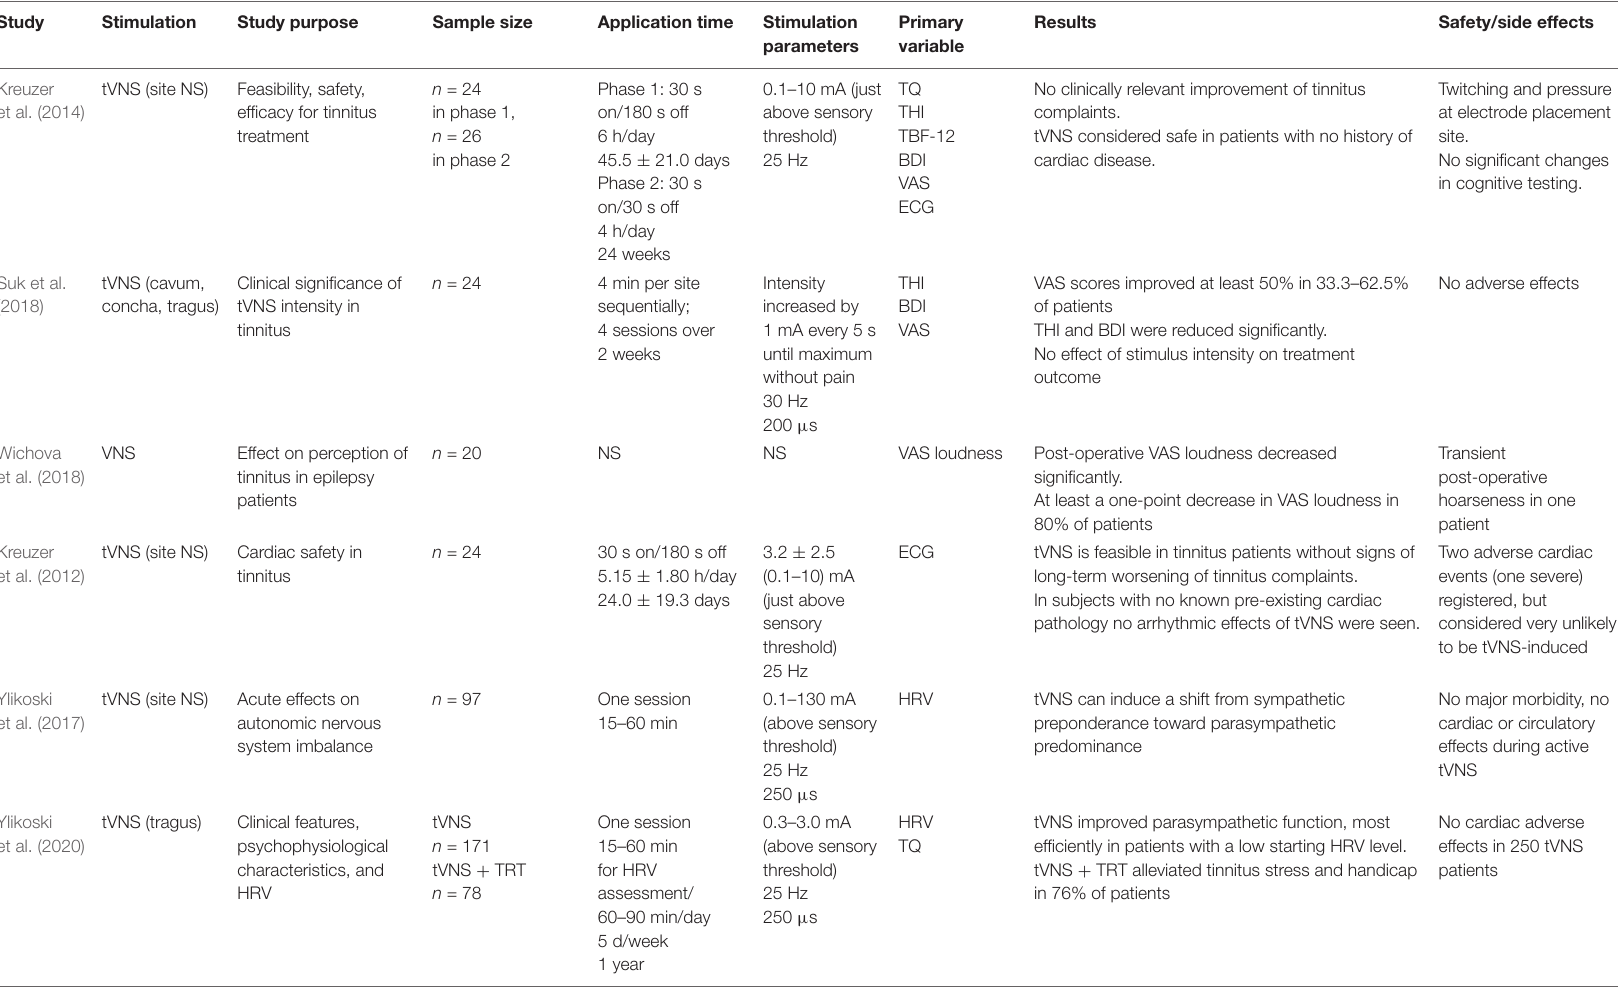
TABLE 4 | Summary of the existing studies on (t)VNS alone (not paired with sound stimuli) in patients with tinnitus.